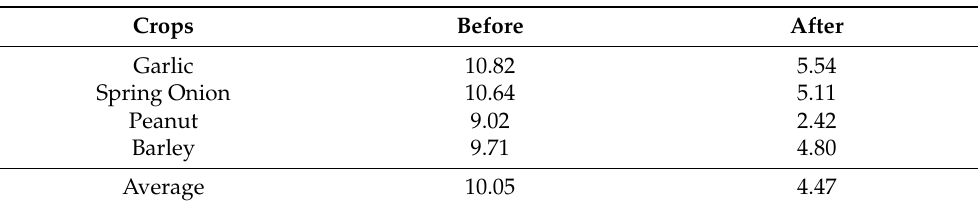
Table 8. Comparison of exceedance probability (%) of irrigation intervals longer than the maximum non-irrigation days, by